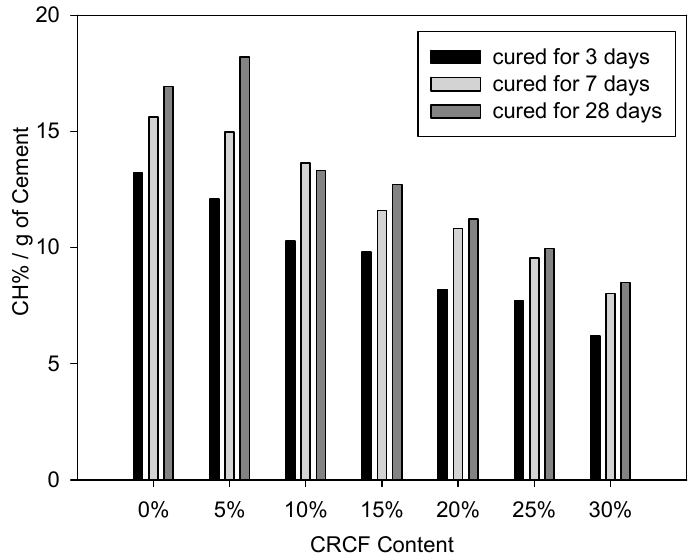
Figure 17. CH content in relation to CRCF contents.